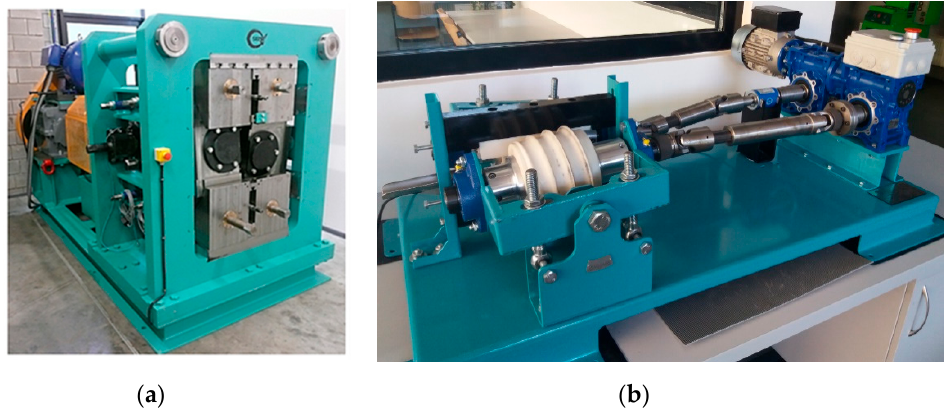
Figure 3. Laboratory stand for helical rolling of ( a ) real material—steel; ( b ) model material— plasticine.